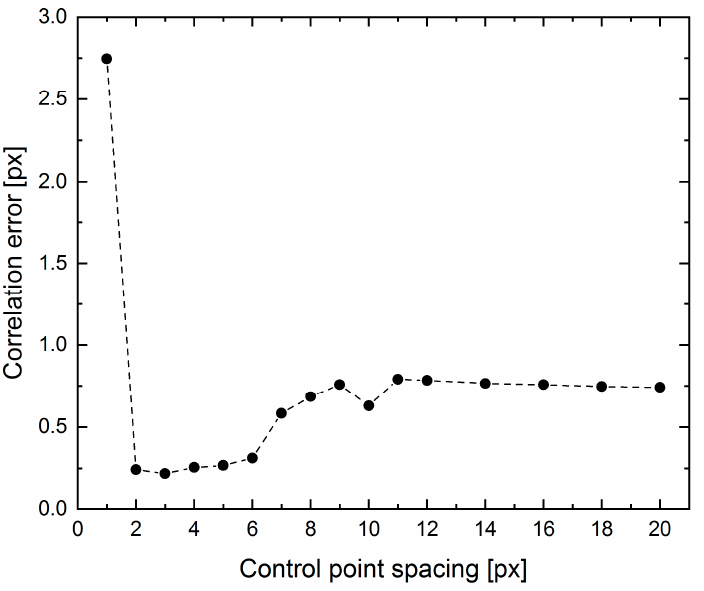
Figure A3. Effect of the control point spacing in the final resolution of the multiresolution approach, namely the final grid spacing, on the correlation